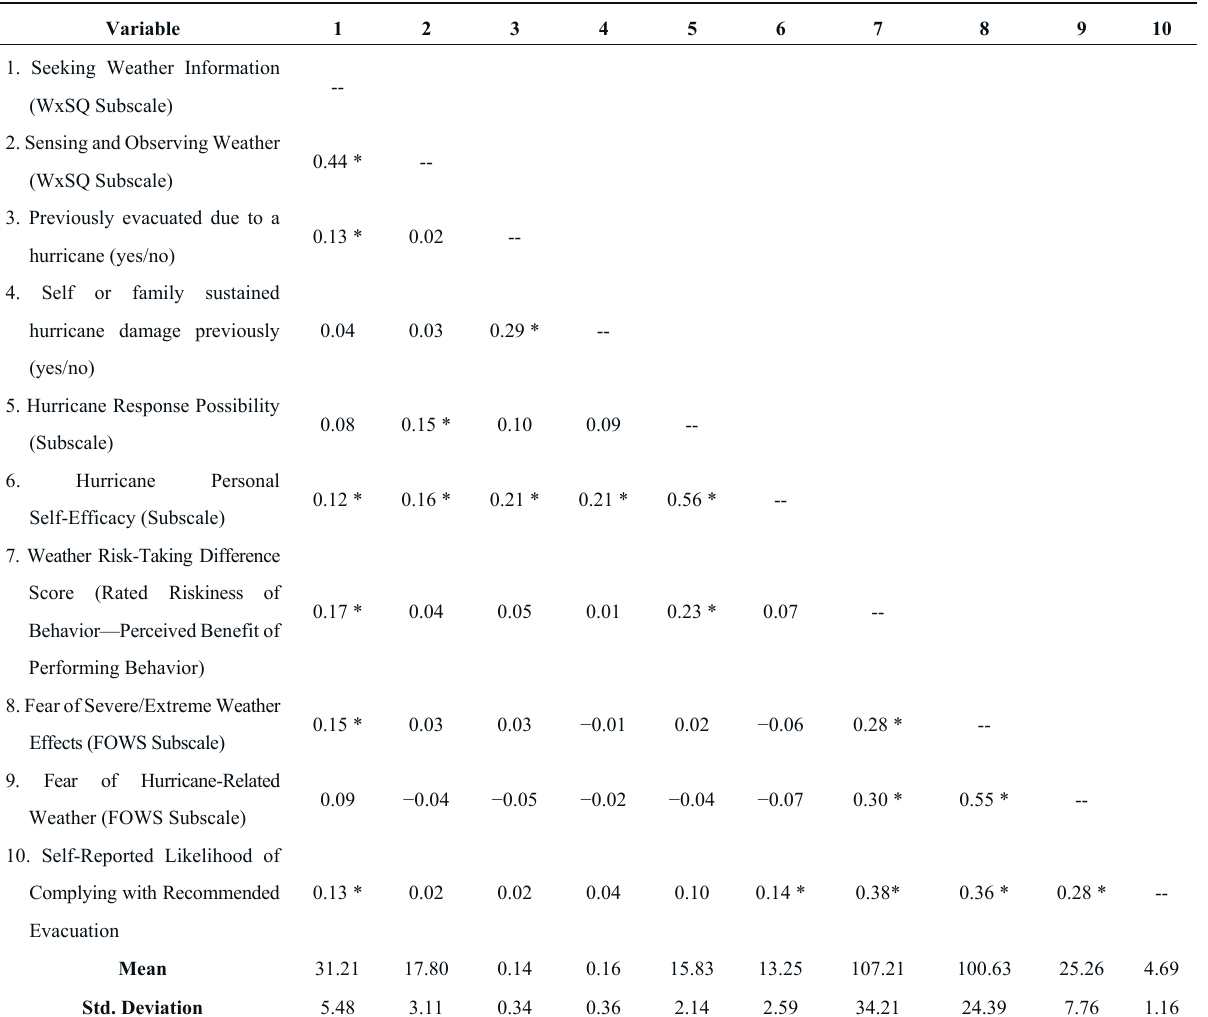
Table 4. Descriptive Statistics and Pearson Correlation Coefficients Ϯ for Variables Considered for the Structural Model of Hurricane Personal Self-Efficacy and its Contribution of Evacuation Likelihood ( n =